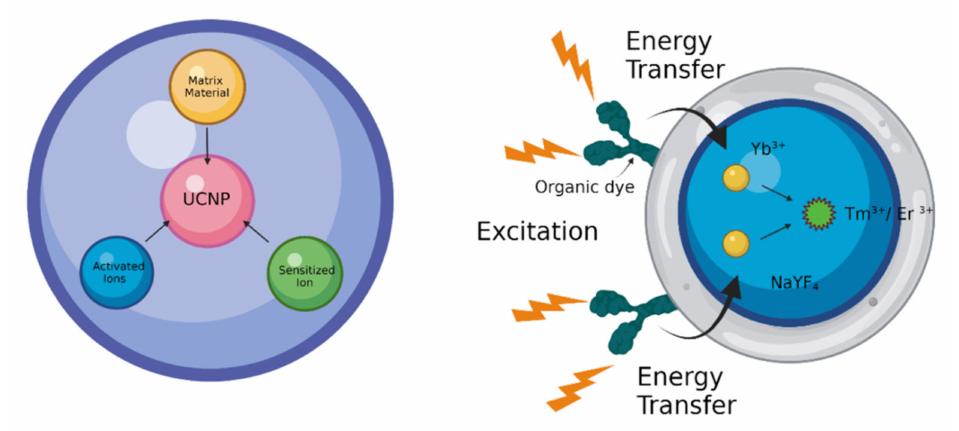
Figure 3. Components of UCNPs and mechanism of energy transfer in